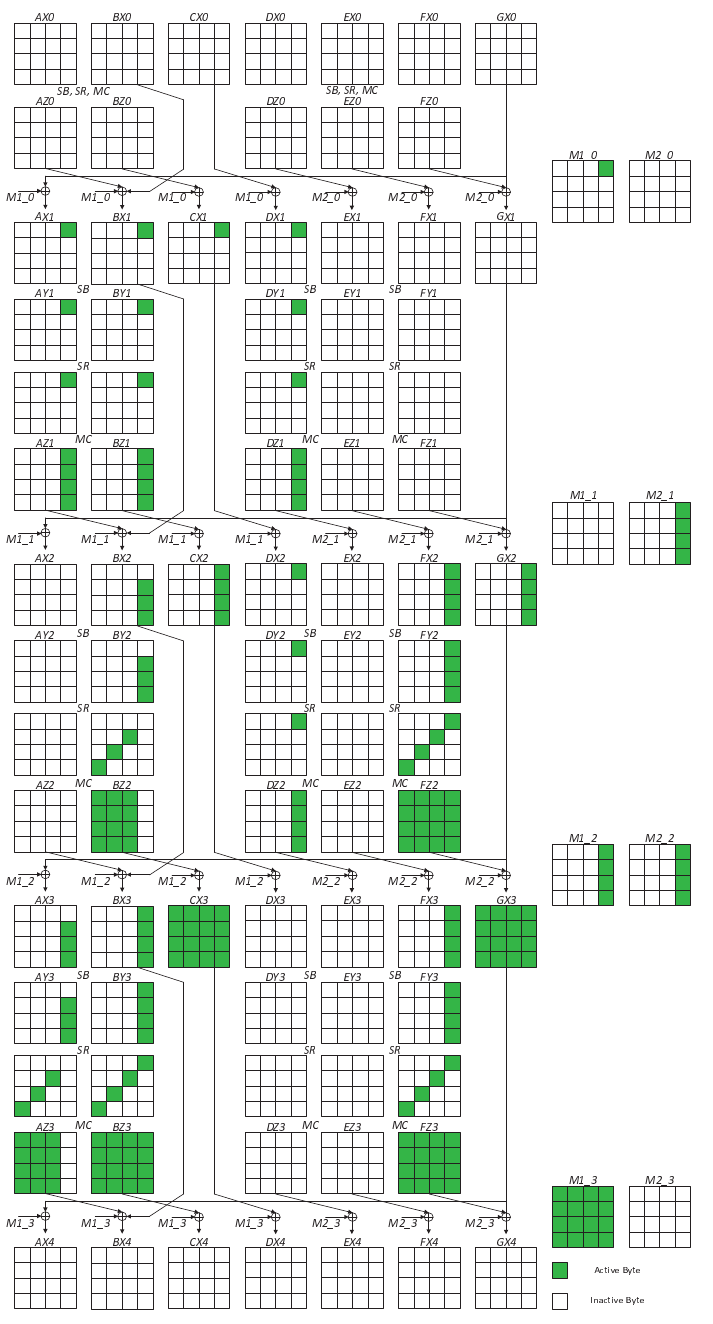
Figure 3: Invalid differential characteristic for C5 with 22 active